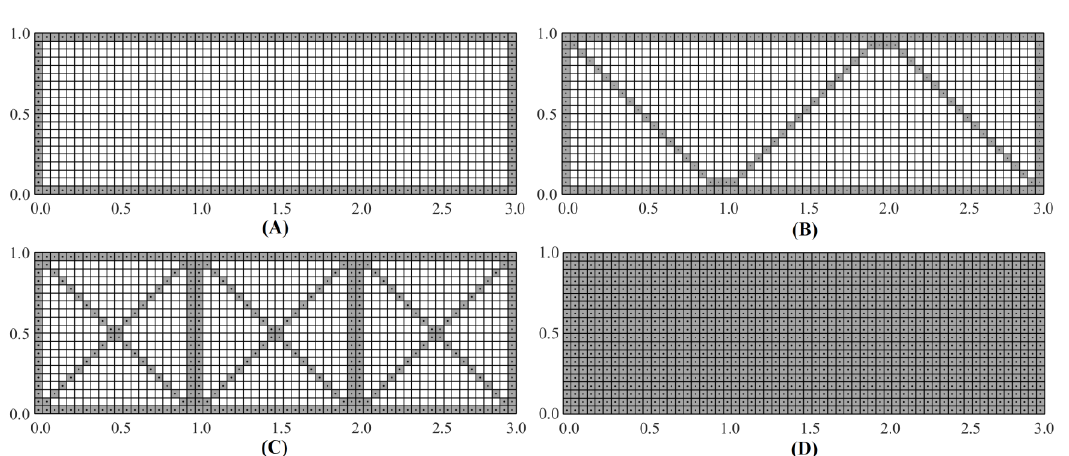
Figure 4. Sensor configurations for the iQS4 mesh; Configuration: ( A ) with strain sensors along the boundaries; ( B ) with strain sensor along diagonal paths arranged in a zig-zag pattern; ( C ) with sensors along cross-diagonal paths; and ( D ) with sensors placed at the centroids of all elements.